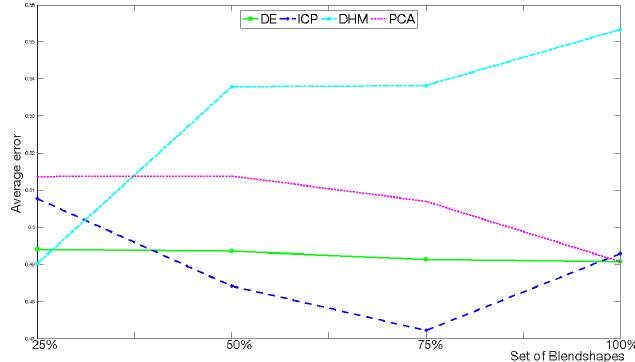
Fig. 14. Visualization of the performance of the algorithms according to the amount of blendshapes